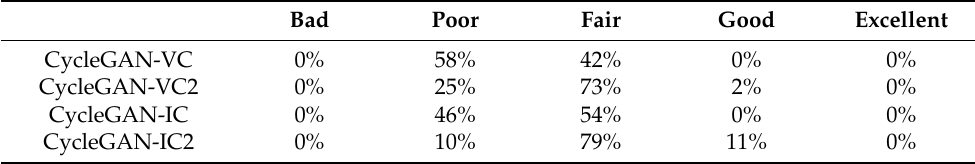
Table 4. The percentage distribution of MOS in humming to viola.